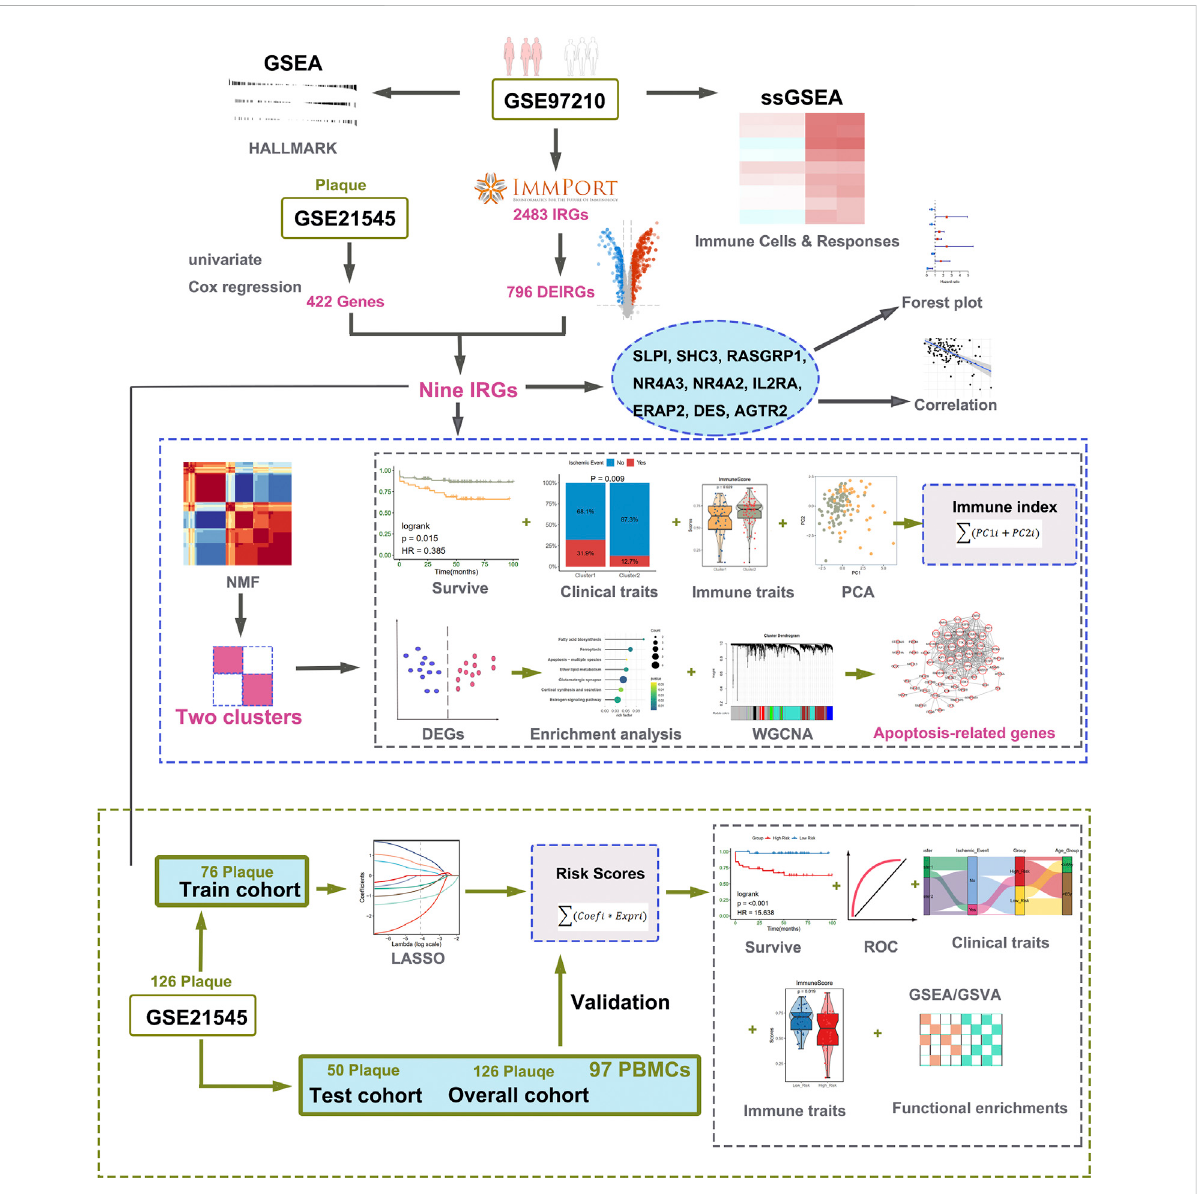
FIGURE 1 Work fl ow of data analysis in our present work. DEGs, differentially expressed genes; IRGs, immune-related genes; DEIRGs, differentially expressedimmune-relatedgenes;GSEA,genesetenrichmentanalysis;ssGSEA,singlesamplegenesetenrichmentanalysis;GSVA,genesetvariation analysis; NMF, Non-negative Matrix Factorization; PCA, principal component analysis; ROC, receiver operating characteristic curve; GO, Gene Ontology; KEGG, Kyoto Encyclopedia of Genes and Genomes; LASSO, least absolute shrinkage, and selection operator; WGCNA, weighted gene co-expression network